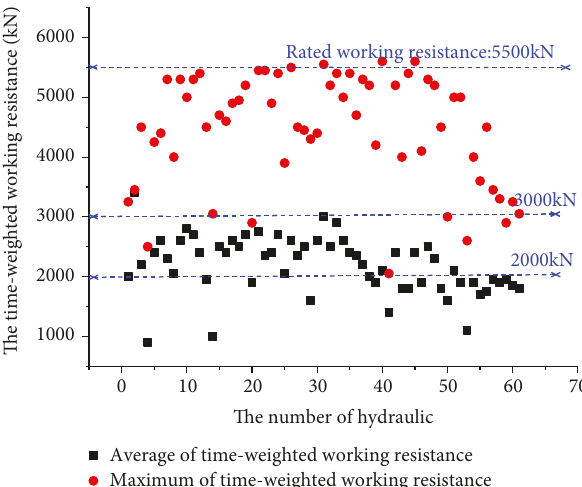
Figure 13: The weighted working resistance distribution of hydraulic